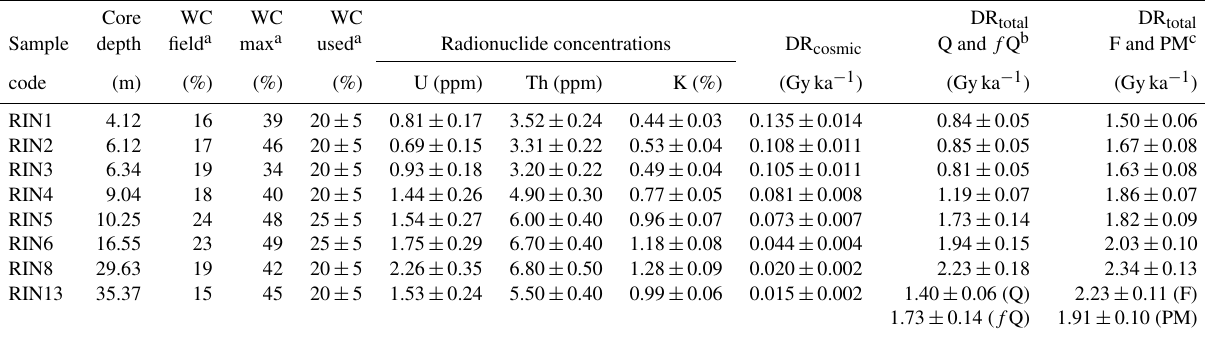
Table 2. Dosimetric data and total dose rates as used for age determination (all values are given with 1 σ uncertainties). Core WC WC WC DR total DR total Sample